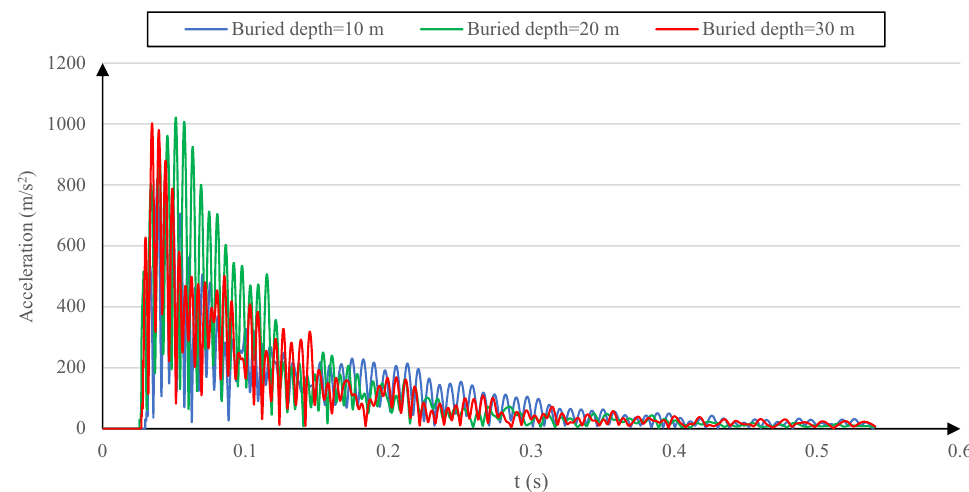
Figure 7. Total surface soil acceleration variation versus time for the cases of 10-m, 20-m and, 30-m buried depth with reference soil properties.